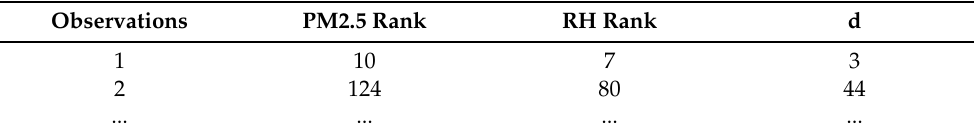
Table 5. Spearman’s Rho Correlation Formula on PM2.5 and Relative Humidity (RH).